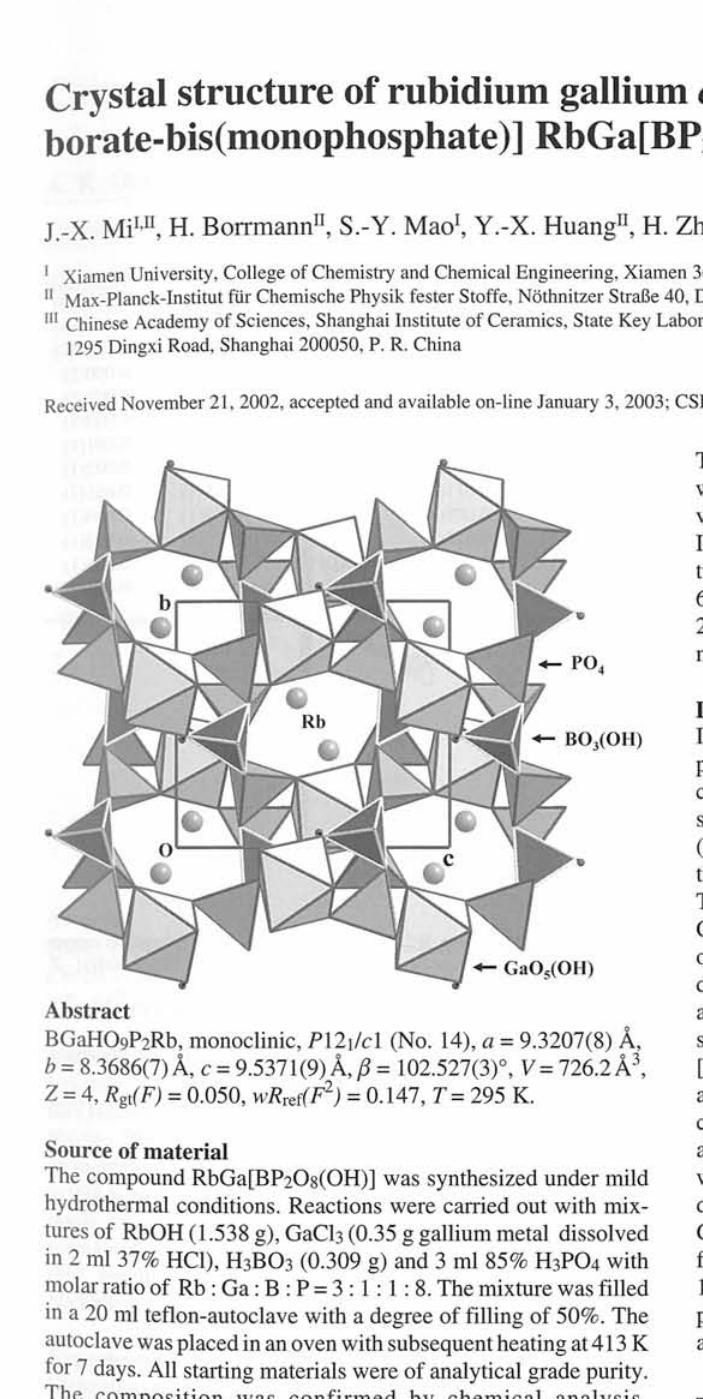
Table 1. Data collection and